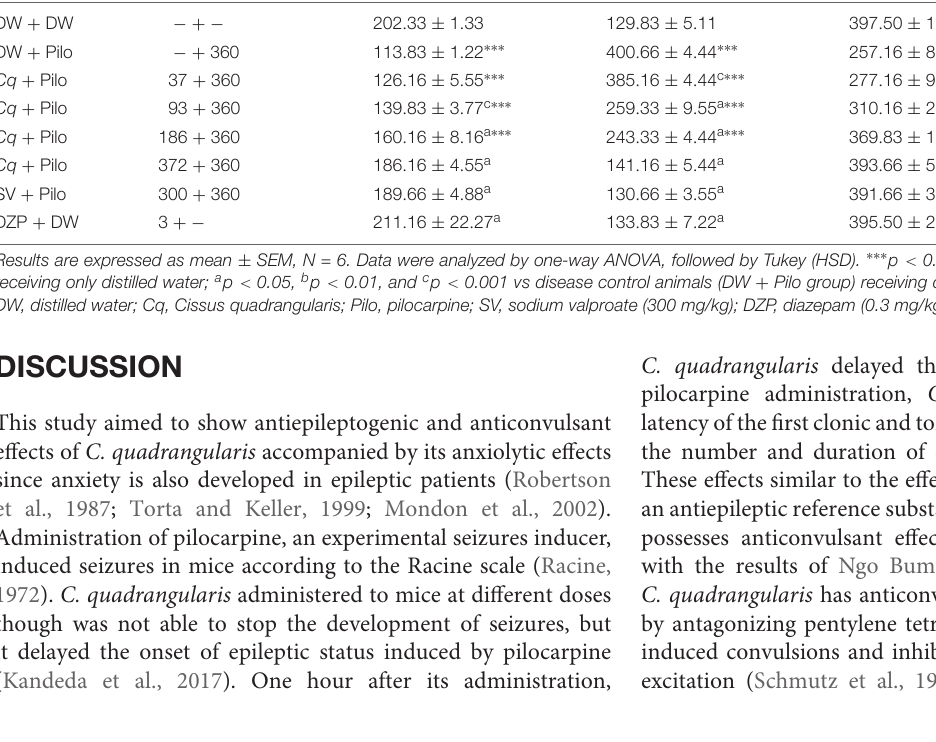
TABLE 3 | Effects of C. quadrangularis on oxidative stress markers in hippocampi of pilocarpine-injected mice.